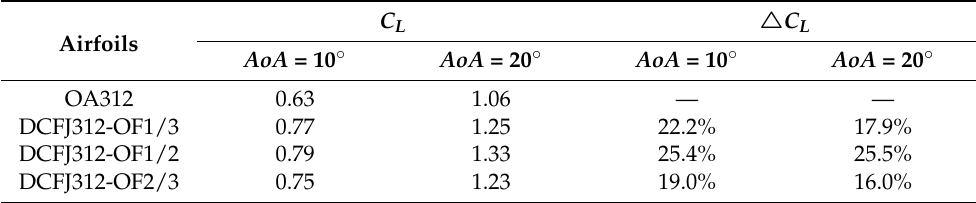
Table 8. Comparisons of maximum lift coefficients and stall AoAs of DCFJ312 airfoils with various OF s.